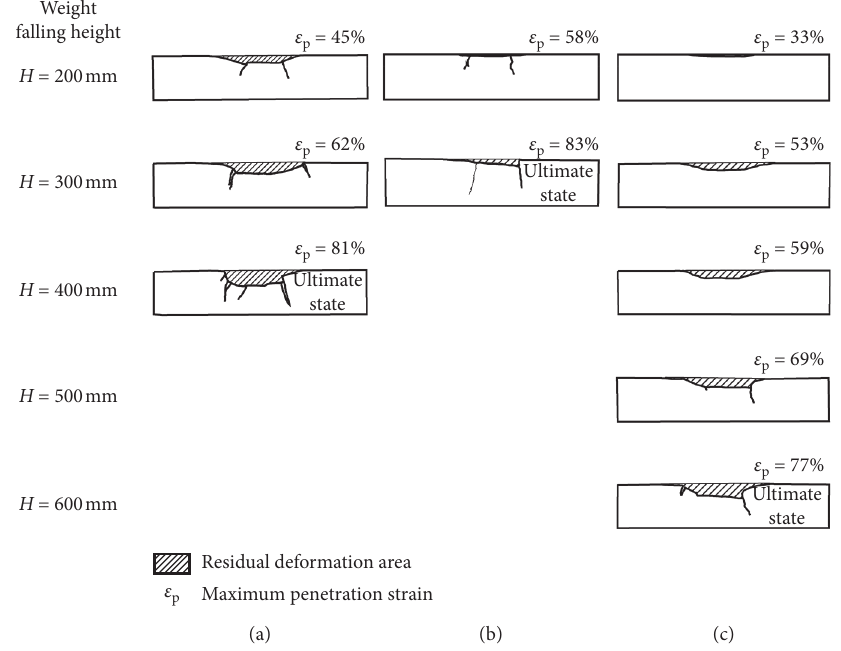
Figure 6: Cut area of the expanded material in the case with core slabs. (a) ST. (b) PP. (c)